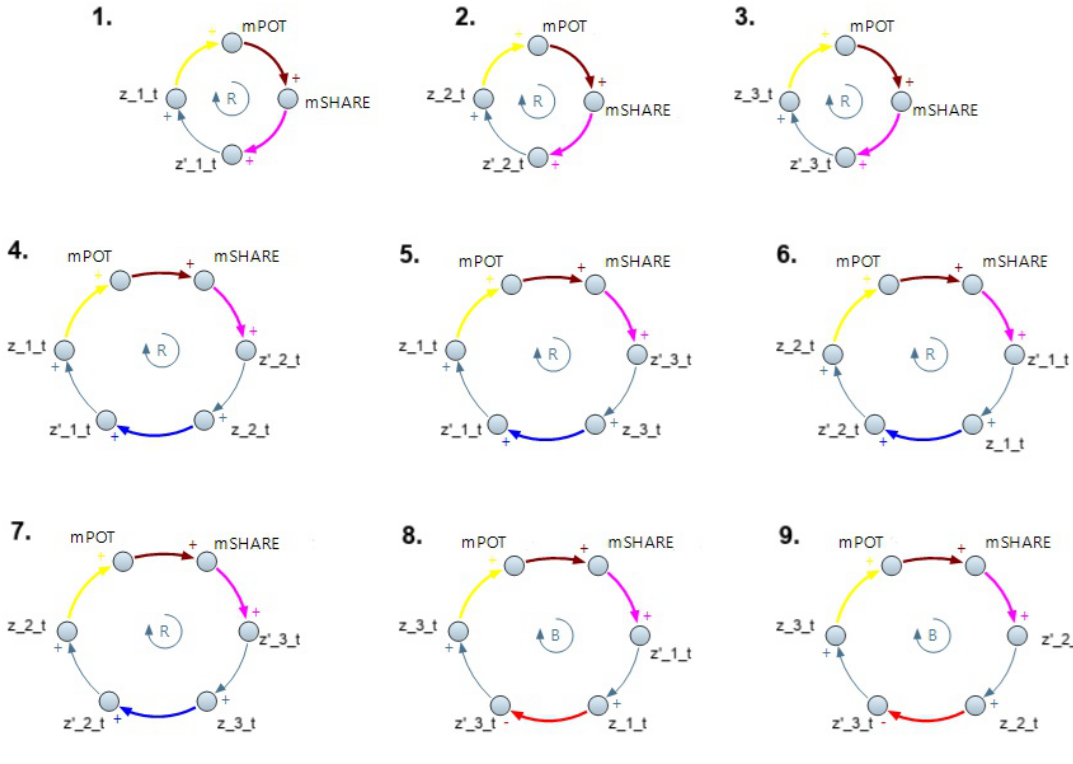
Figure 4. UCTT-SFN relevant feedback loops. Cause–effect relationships affecting market potential (yellow), market share (brown). Cause–effect relationships determined by market share (purple), cumulative consumptions on the same (internal-influence, in gray), as well as on different (cross- influence, positive in blue and negative in red)